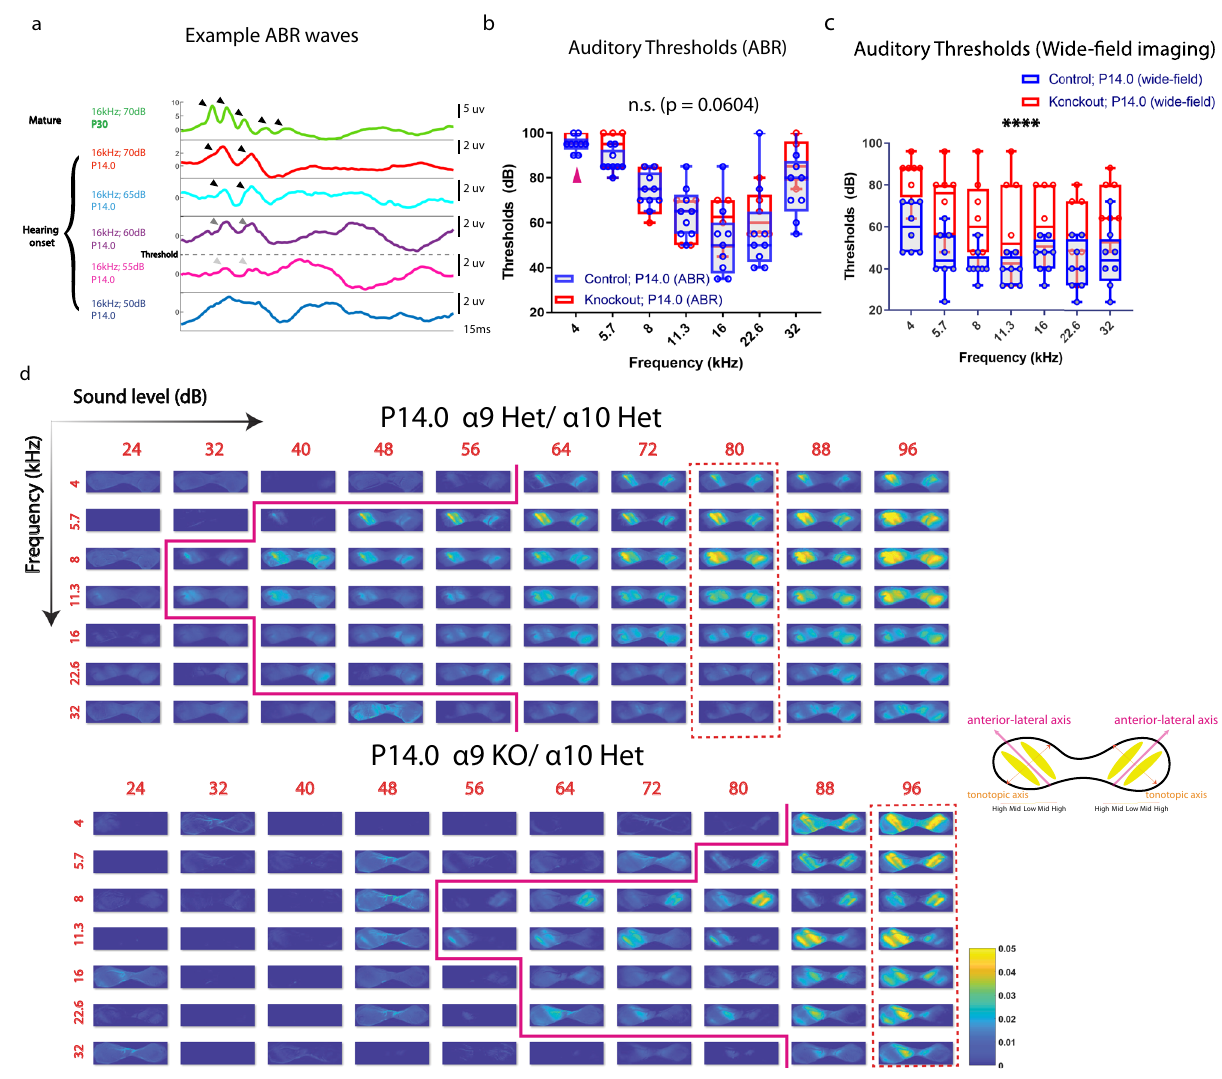
Fig. 5 Elevation of auditory thresholds in α 9/ α 10 nAChR knockouts at the hearing onset. a Snapshots of example auditory brainstem response (ABR) curves. White arrowheads indicate ABR waves. Scale bar indicates 2 µ V. The White dashed line represents the detection threshold. b Auditory thresholds measured by auditory brainstem response (ABR) in control and α 9/ α 10 nAChR knockout animals at P14.0. A number of animals: Control P14.0 = 9 (GCaMP6s negative littermates of animals used in ( e )). α 9/ α 10 knockout P14.0 = 6. Magenta arrowheads indicate that part of the data is not available in the knockout group (two animals did not respond to 4 kHz tones.). n.s., two-way ANOVA, F = 1.409, p = 0.0604 on the column (genotype) factor. c Auditory thresholds measured by wide- fi eld imaging. A number of animals: Control = 8 (wide-type SNAP25-G6s = 6; α 9/ α 10 double heterozygous SNAP25-G6s = 2). Knockout = 8 (mix of single knockout of either α 9 or α 10 subunit and double knockout). Two-way ANOVA, F = 31.98, **** p < 0.0001 on the column (genotype) factor. d Example Δ F / F 0 response images to different acoustic stimuli. Row direction: Sound level. Column direction: frequency. Solid magenta lines denote the auditory thresholds at different frequencies. Dashed red rectangles highlight columns of responses to different frequencies at the same SPL level (tonotopy). Het heterozygous, KO knockout. Colormap: parula (MATLAB). Top image array: an example from a P14.0 α 9/ α 10 double heterozygous control. Bottom image array: an example from its P14.0 α 9 knockout α 10 heterozygous littermate. Schematics in the middle: major axes and tonotopic reversals in the two hemispheres of the IC. Box plots in Fig. 5: hinges: 25 percentile (top), 75 percentile (bottom). Box whiskers (bars): Max value (top), Min value (bottom). Source data and exact p values are provided as a Source Data fi